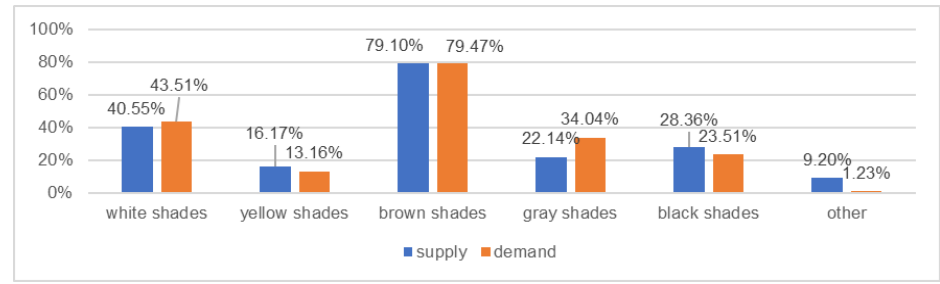
Figure 8. Comparison of supply and demand for specific colour tones of WFPs.